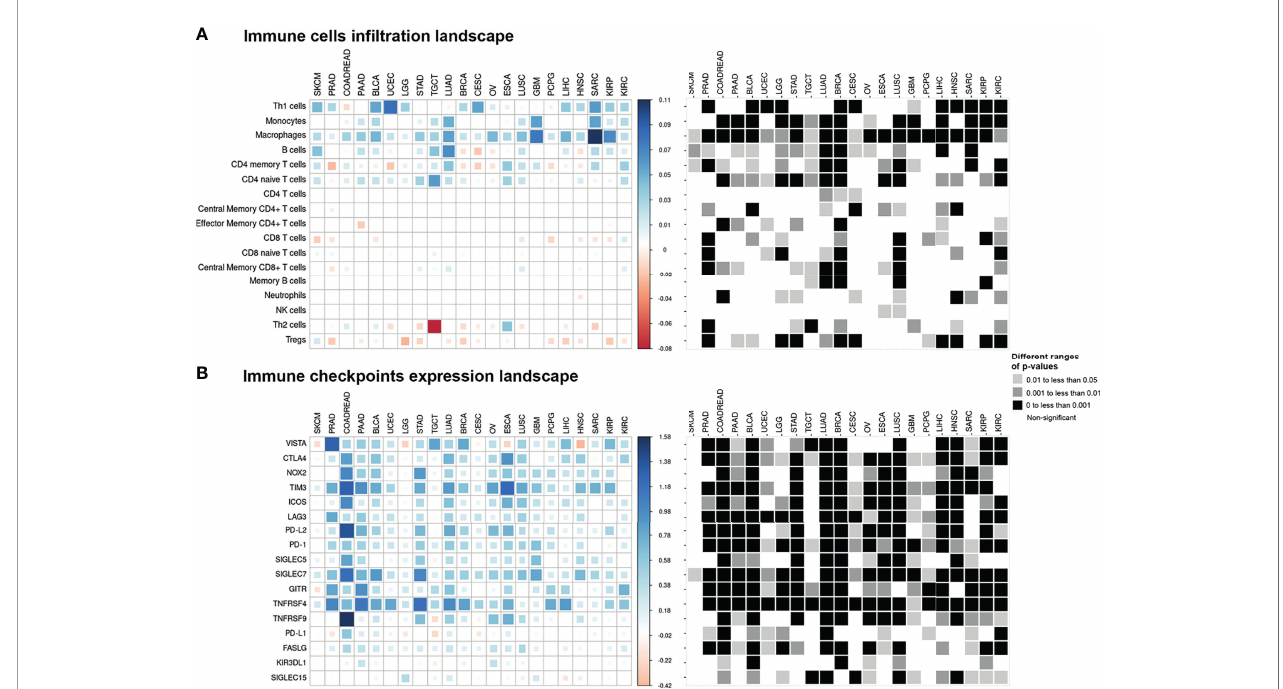
FIGURE 3 | Pan-cancer immune cell in fi ltration and immune checkpoint expression landscape: The colored squares represent the difference between: (A) the medians of immune cell enrichment score of epithelial – mesenchymal transition (EMT)-high (mesenchymal) and EMT-low (epithelial) samples of each cancer type and (B) the medians of expression of immune checkpoints in EMT-high and EMT-low samples of each cancer type. The larger sized and darker blue or red shaded squares correspond to a greater difference. Grayscale squares on the right side represent the corresponding p-values for differences between EMT-high and EMT- low groups of tumors.